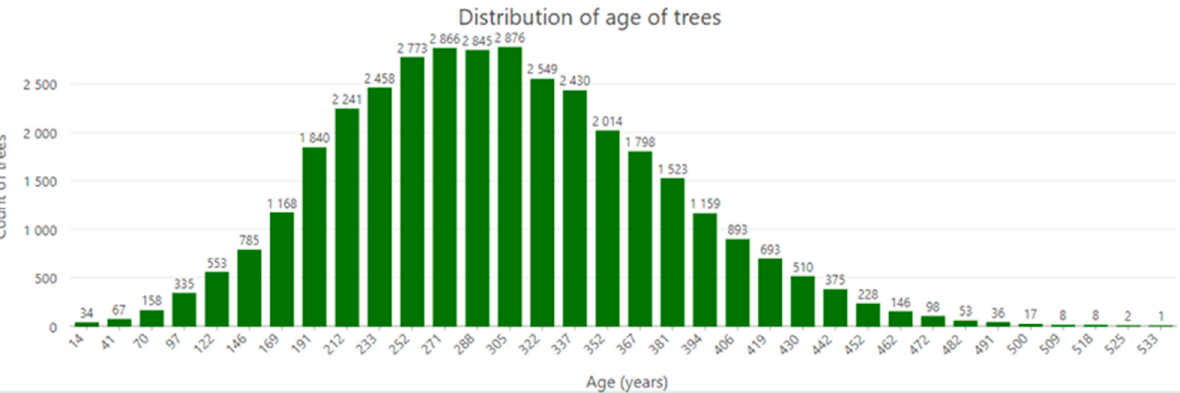
Figure 8. Distribution of estimated Dracaena tree ages (calculated on the projected crown sizes) in Firmihin. in Firmihin.